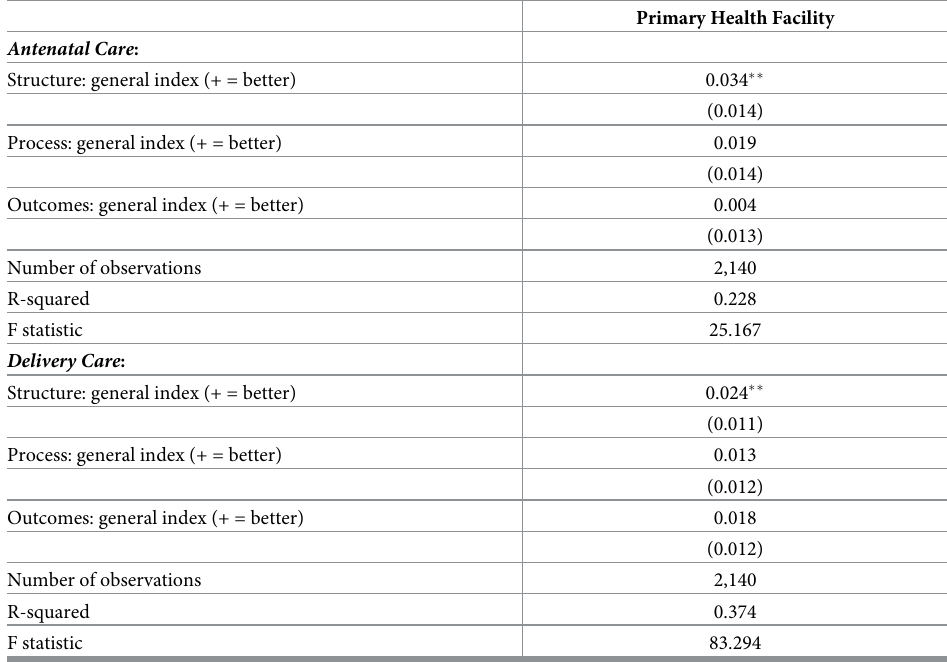
Table 5. Dimensions of care quality and the utilization of obstetric care.